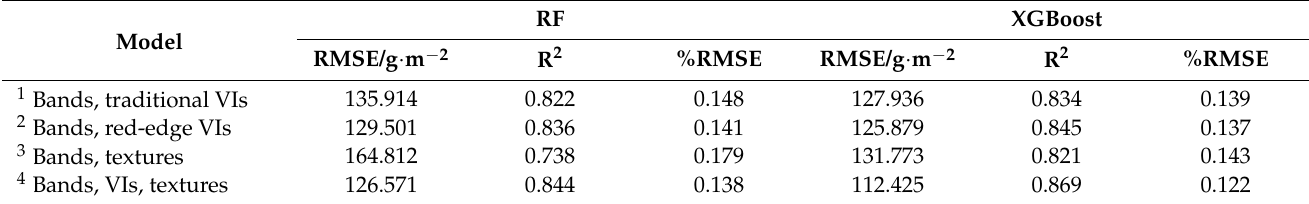
Table 3. Performance of the RF and XGBoost models for AGB estimation using the training data set. Model